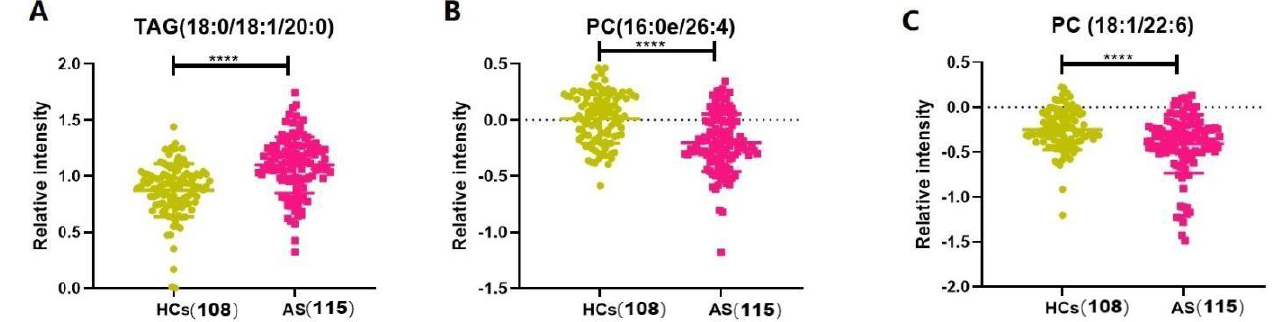
Figure 4. Serum-relative intensities of TAG (18:0/18:1/20:0), PC (16:0e/26:4), and PC (18:1/22:6) in the HCs and AS groups. ( A , B ) The levels of TAG (18:0/18:1/20:0) and PC (16:0e/26:4) were increased in the patients with AS ( p < 0.0001). ( C ) The levels of PC (18:1/22:6) were decreased in the patients with AS ( p < 0.0001). **** p < 0.001.